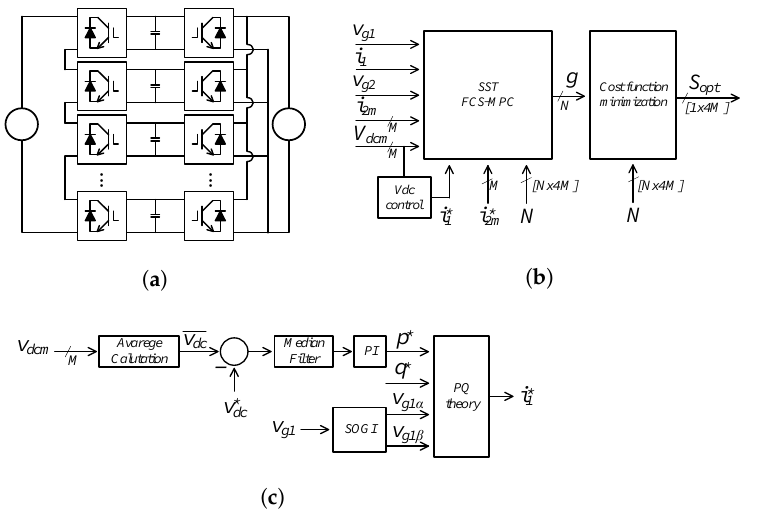
Figure 13. Generic M -modules ISOP CHB-B2B converter: ( a ) topology configuration, ( b ) MPC diagram block, ( c ) primary side current reference